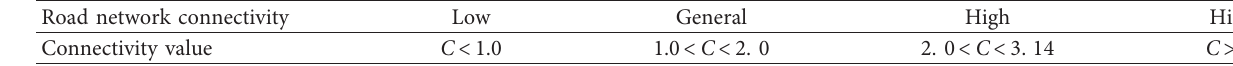
Table 2: Different connectivity values of different planned target road networks.